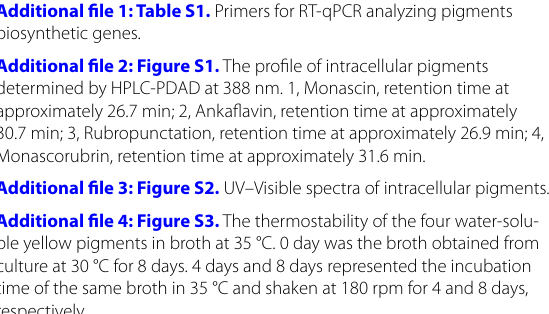
Additional file 3: Figure S2. UV–Visible spectra of intracellular